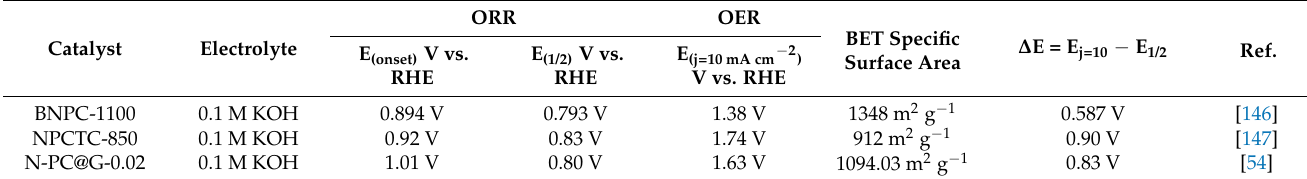
Table 3. Summary of ORR/OER performance of MOF-based metal-free catalysts.